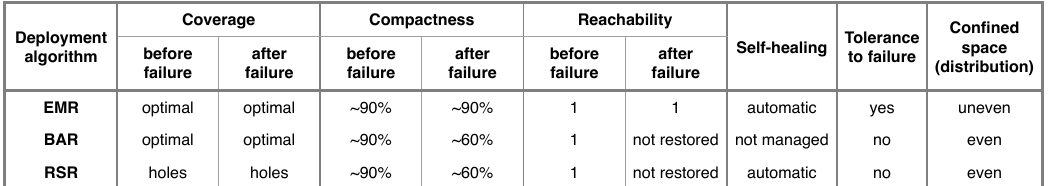
Tab. 1: Comparison of the algorithms – a